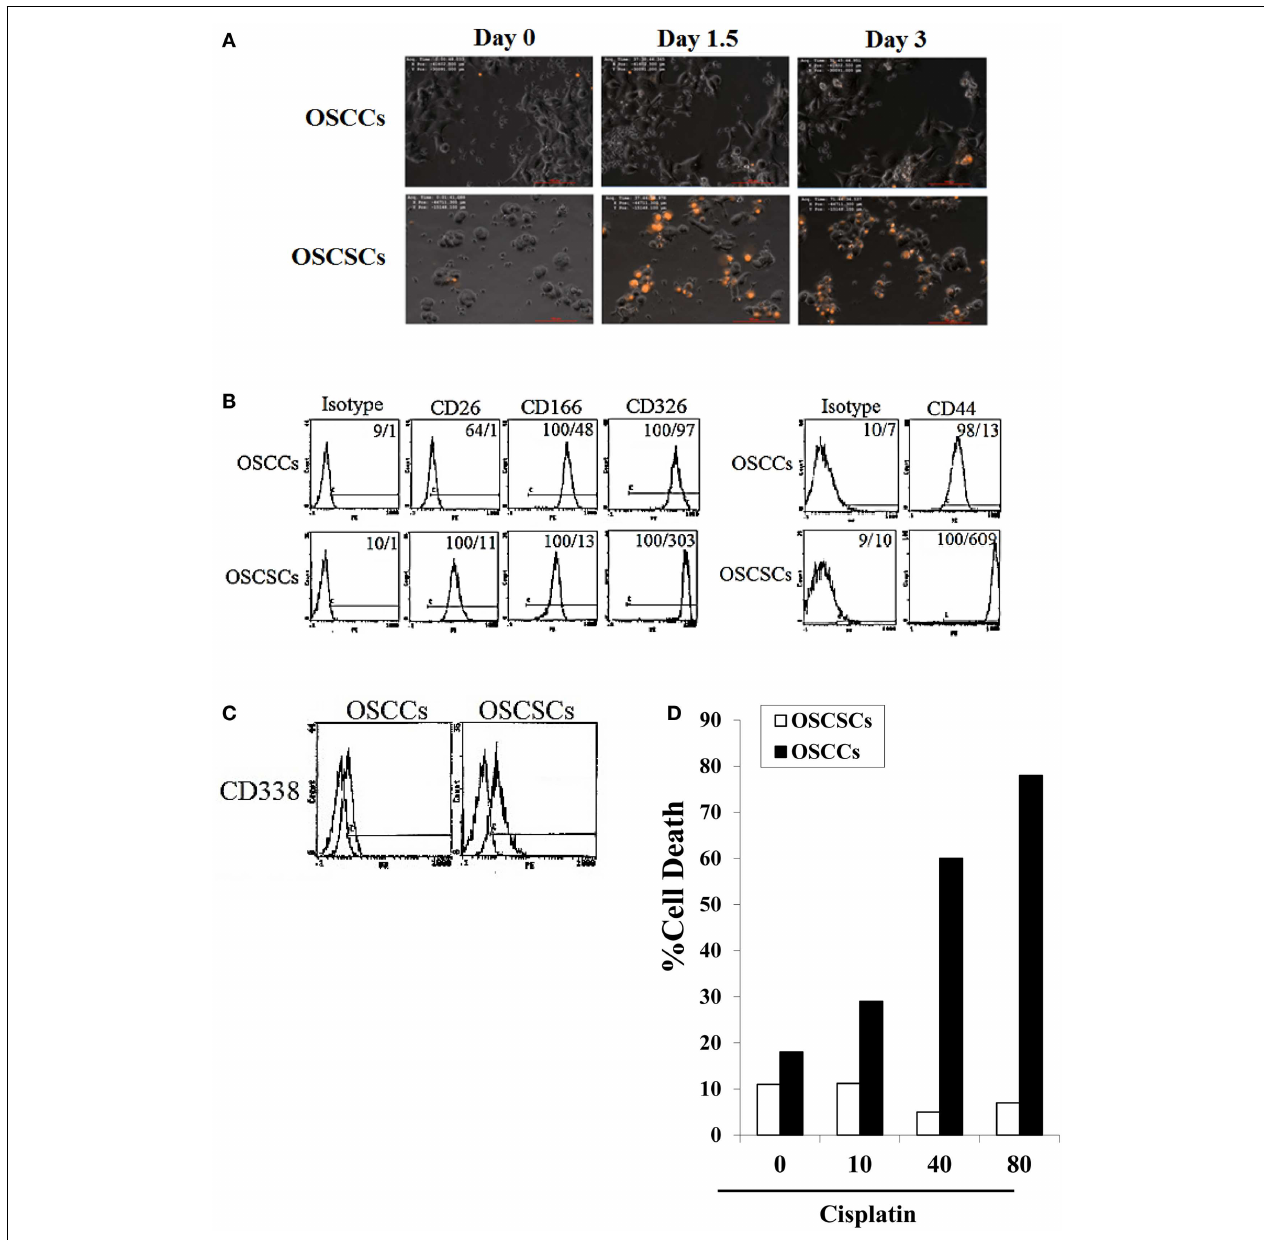
were assessed with flow cytometric analysis after staining with the respective PE-conjugated antibodies. Isotype control antibodies were used as control.The numbers on the right hand corner are the percentages and the mean channel fluorescence intensities for each histogram (B) .The surface expression of CD338 on OSCCs and OSCSCs was assessed by flow cytometric analysis after staining with PE-conjugated CD338 (right graphs in the histogram). Isotype control antibodies were used as control (left graphs in the histograms) (C) . OSCCs and OSCSCs were left untreated or treated with 10–80 µ g/ml of cisplatin for 18h, after which the tumor cells were washed with 1 × PBS, detached, and stained with propidium iodide (PI) and percent cell death was determined using flow cytometric analysis (D) . NK cells were left untreated or treated with IL-2 (1000units/ml), anti-CD16 mAb (3 µ g/ml), or a combination of IL-2 (1000units/ml) and anti-CD16 mAb (3 µ g/ml) for 18h before they were added to 51 Cr-labeled OSCSCs and OSCCs (E) or undifferentiated and differentiated DPSCs (G) .